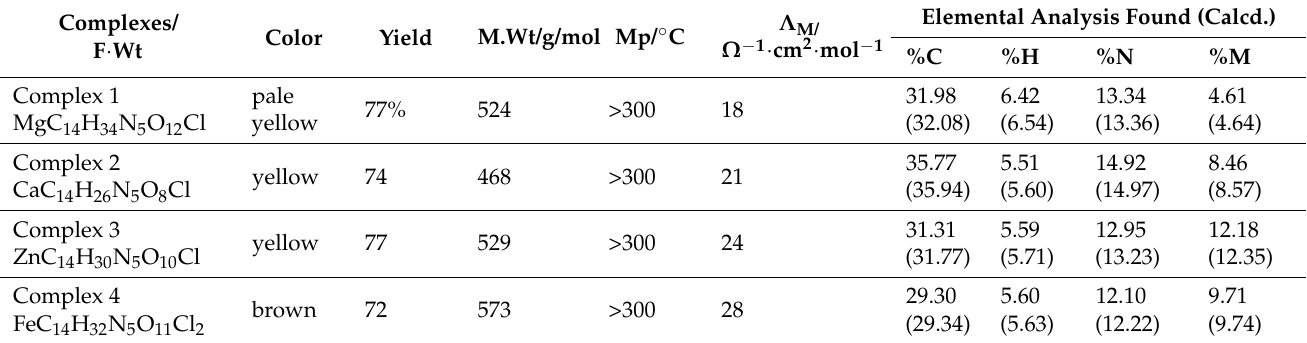
Table 1. Microanalytical and physical data of pipemidic acid